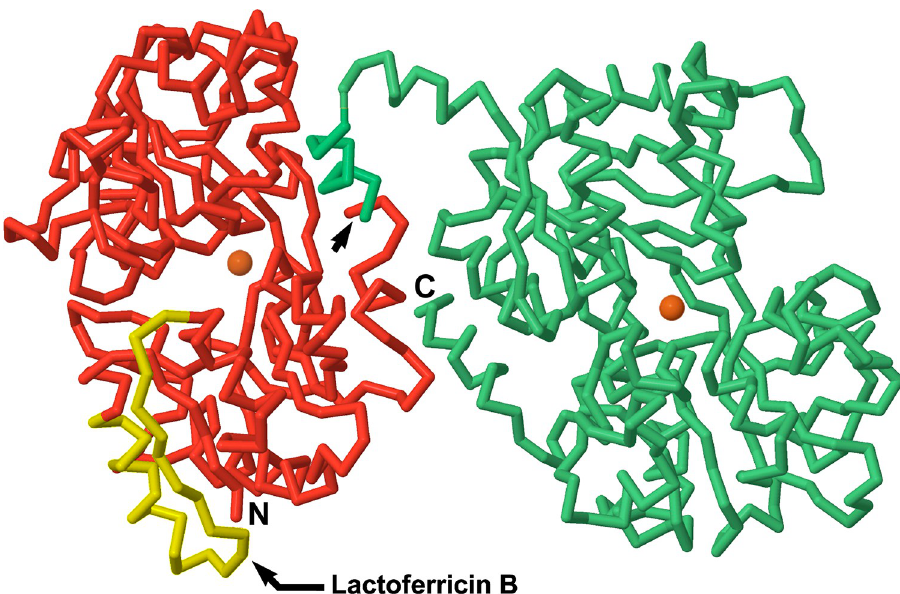
Fig 11. Three-dimensional image of the largest fragments. The 37 kDa N-lobe fragment is shown in red-and-yellow, and the 43 kDa C-lobe fragment is shown in green. The arrow near the center of the image shows the single peptide bond that was clipped to generate the two fragments. The iron atoms bound within each lobe are shown as orange spheres. The antimicrobial peptide portion of the N-lobe, lactoferricin B, is highlighted in yellow. It remains an integral portion of the 37 kDa fragment and reacts with its mAb on western blots. The C-lobe antigenic site is integral to its fragment as well. It is located on the far side of the green polypeptide segment and is not visible